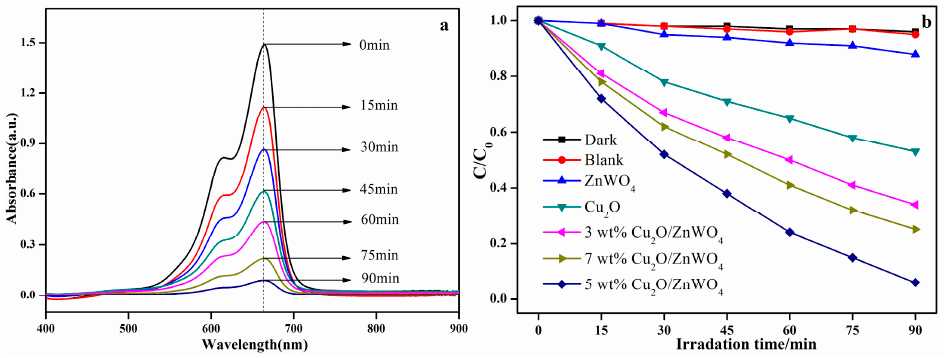
Figure 8. ( a ) UV-Vis spectral changes of methylene blue (MB) aqueous solution in the presence of 5 wt % Cu 2 O/ZnWO 4 photocatalyst; ( b ) the activity of different catalysts to degrade MB in visible light.